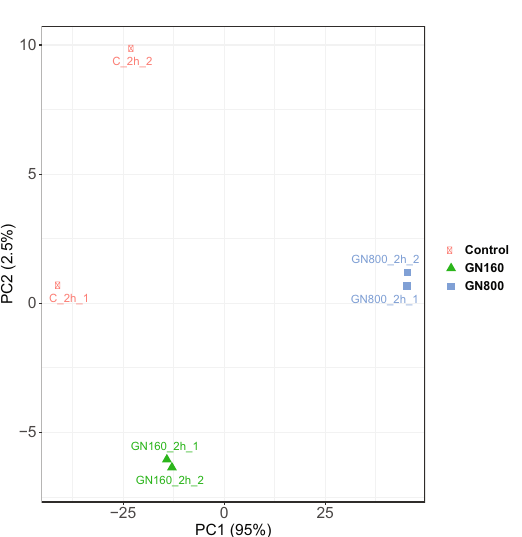
Figure 3. Comet assay for DNA damage analysis on S. cerevisiae cells through the quantification of tail DNA % ( a ), tail moment ( b ) and olive tail moment ( c ) parameters in non-exposed cells (negative control; C − ), cells exposed to 10 mM of H 2 O 2 (positive control; C + ) and cells exposed to 80 mg L − 1 of GN. The reported values are the averages of three biological replicates per culture condition.